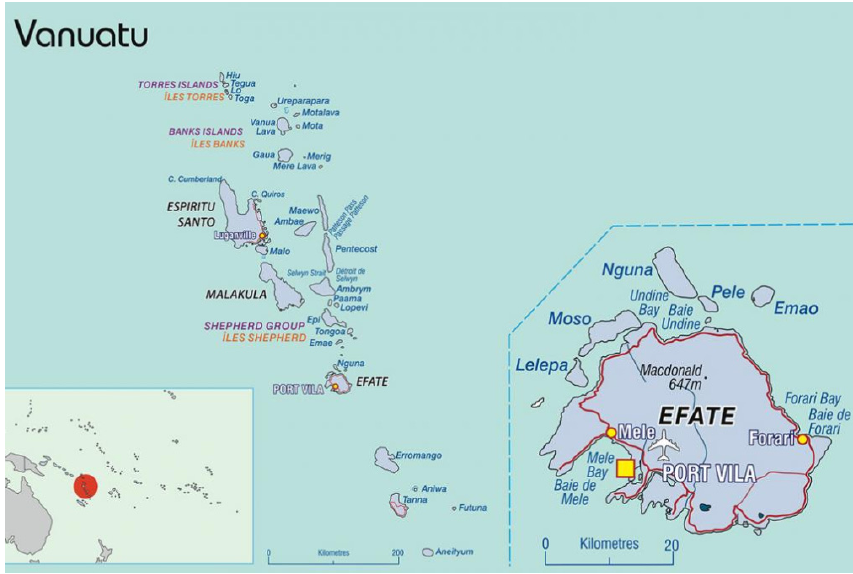
Figure 1. Map of Vanuatu showing Port Vila, the capital on the Island of Efate. Map was obtained with permission of the Pacific Community (SPC) http://spc.int.